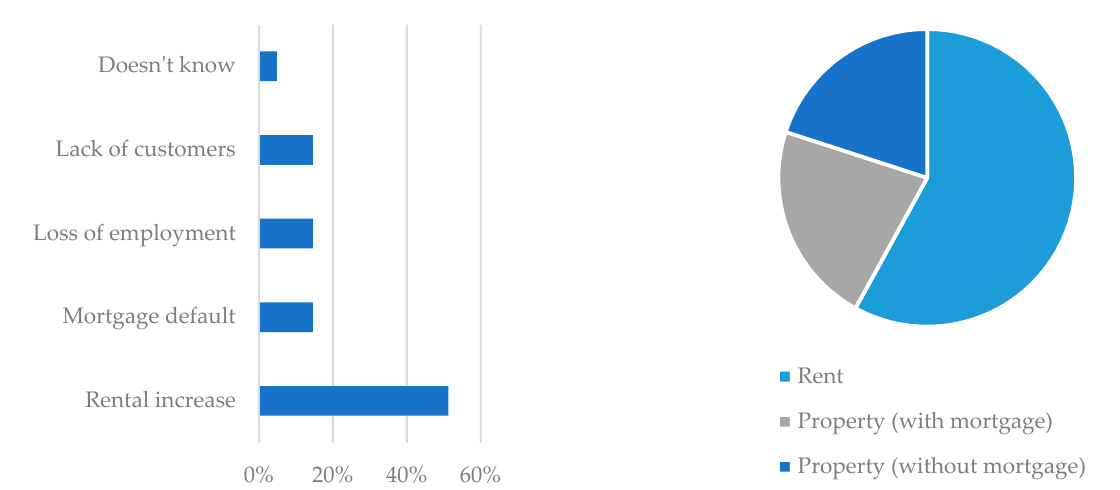
Figure 4. Reasons for dispossession ( left ) and type of ownership ( right ). Own elaboration. The interviewees related their experiences of dispossession mostly to Los Cristianos and Playa de Las Am é ricas, in part also to Tenerife and Lanzarote, i.e., to nearby